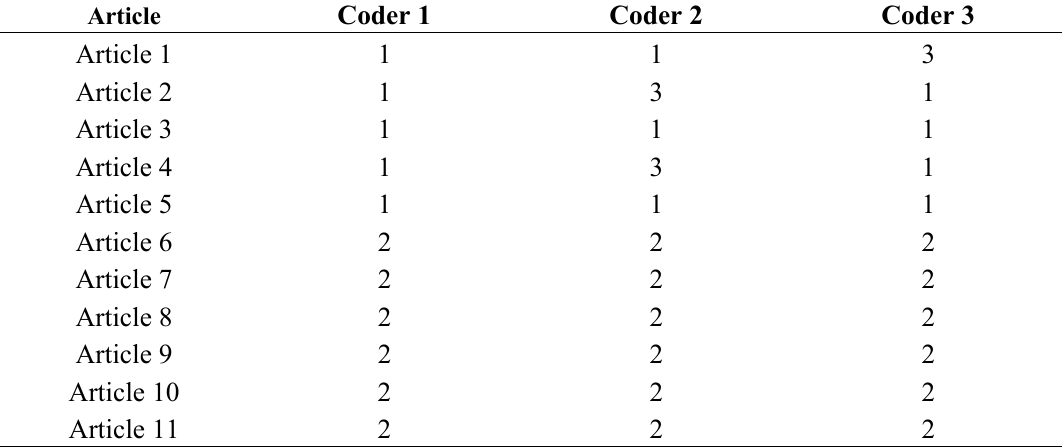
Table 1. Ratings by coders of acceptability of randomly selected